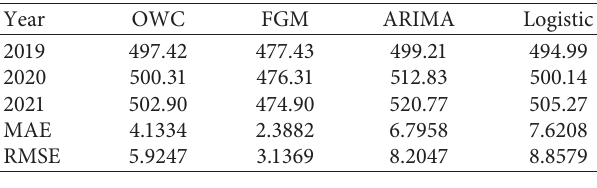
Figure 2: Comparison graph of Huizhou population development trend estimated by the optimal weighted group model and the fractional grey model. Table 2: Test results of the prediction